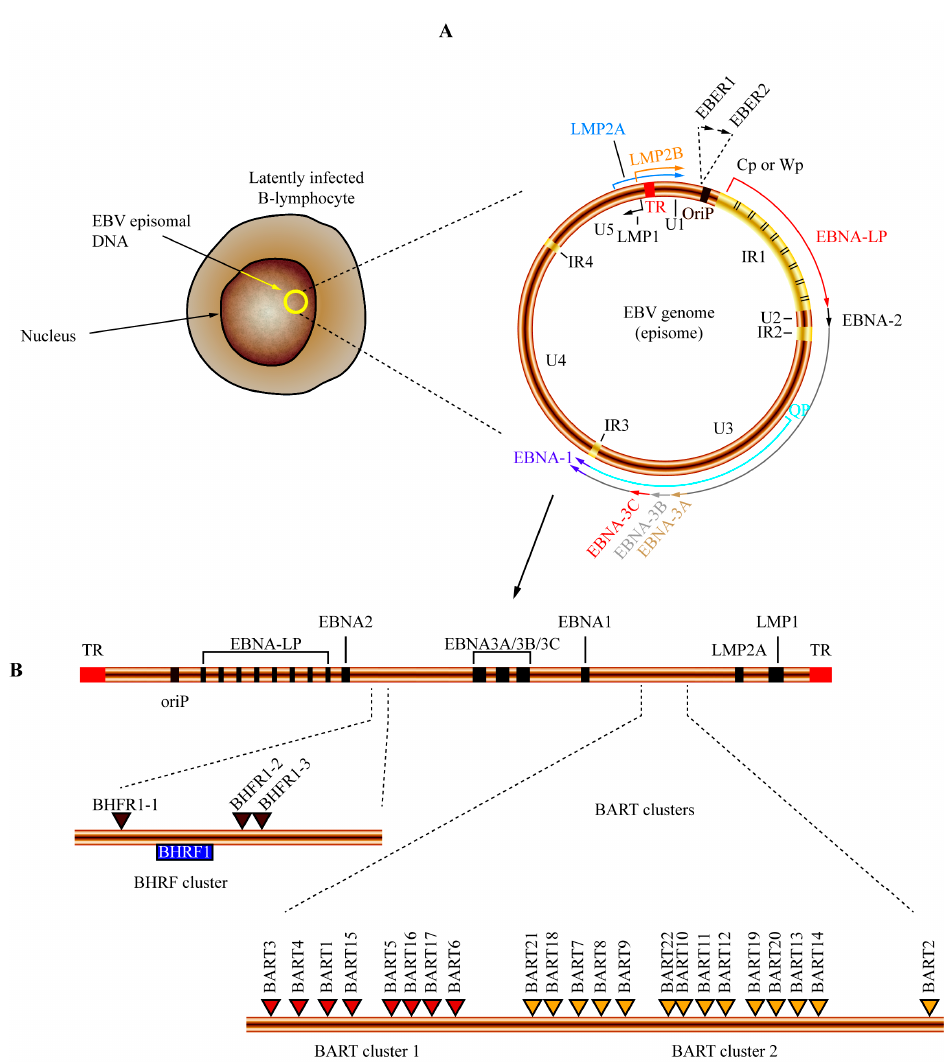
Figure 3. Genome organization and location of miRNAs encoded by the Epstein–Barr virus (EBV). ( A ) After primary infection, EBV establishes a latent infection in B-lymphocytes. During latency, the EBV genome is maintained as a circular episome (represented as a yellow circle inside the nucleus). The general structure of episomal DNA is presented, and the relative positions of the latency-associated genes on the viral episome are shown. The origin of plasmid replication (oriP) is shown in brown. The outer circle represents the coding regions of the latent proteins transcribed in antisense (LMP1, black arrow) and sense orientation (EBNA-LP, red; EBNA2, black; EBNA3A, light brown; EBNA3B, light grey; EBNA3C, red; EBNA1, purple; LMP2A, blue; LMP2B, orange). EBNA-LP is transcribed from variable numbers of repetitive exons (denoted by black lines inside the IR1 region). The highly transcribed non-polyadenylated RNAs EBER1 and EBER2 are represented in the top of the diagram. The outer long circular arrow represents the EBV transcript during the latency III program where all the EBNA genes are transcribed from Cp or Wp promoters. The inner blue arrow line represents the EBNA1 transcript originated from the Qp promoter during latency I and latency II programs. U1-U5 refers to largely unique DNA domains while IR1-IR4 represents internal repetitive DNA domains. TR (represented in red) denotes the terminal repeat of EBV DNA; ( B ) Genomic location of miRNAs encoded by EBV. A linear representation of EBV genome is shown and the positions of the main latent genes are represented by black boxes; a dark brown box denotes oriP position. The regions of the BHRF cluster and BART clusters 1 and 2 are expanded in the bottom of the diagram. The locations of miRNA precursors are denoted by brown (BHRF cluster), red (BART cluster 1) and yellow (BART cluster 2) triangles.